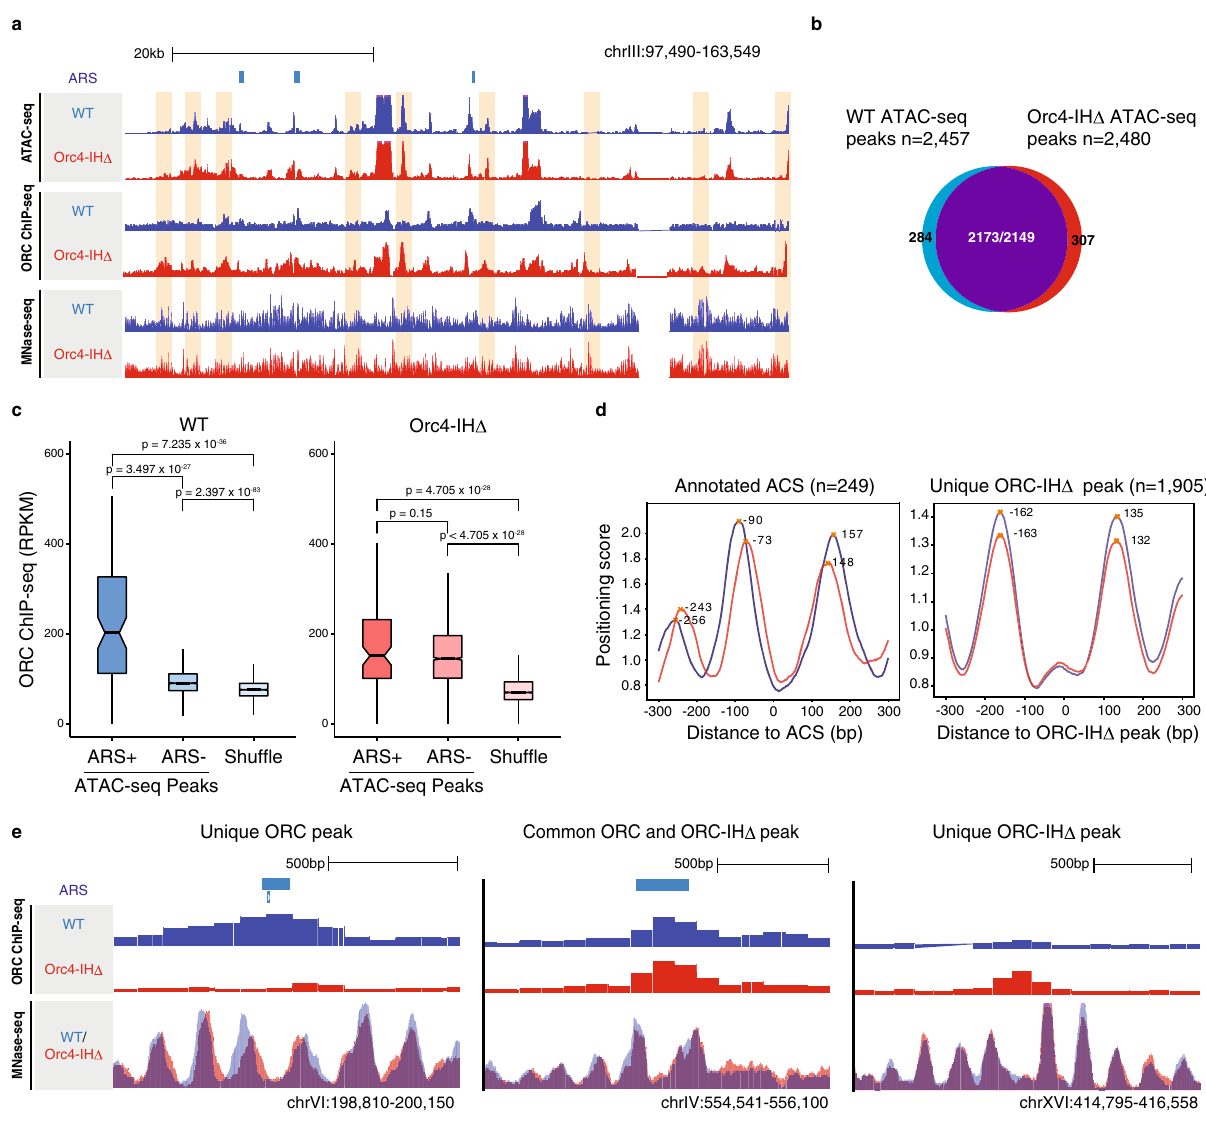
Fig. 6 ORC-IH Δ binds promiscuously to open chromatin and fails to facilitate nucleosome repositioning at ACSs. a A genome browser screenshot of a large region on chromosome III showing the chromatin accessibility, ORC enrichment, and nucleosome positioning in WT compared to Orc4-IH Δ . Orc4- IH Δ demonstrates a bias in binding to ATAC-seq peaks (orange shading). Annotated ARSs are denoted on the top track by light blue bars. Y -axis for all ChIP-seq, ATAC-seq, and MNase-seq tracks was adjusted to the same scale for each assay. b Venn diagram showing the high degree of overlap between ATAC-seq peaks de fi ned in WT ( n = 2457; blue) and Orc4-IH Δ cells ( n = 2480; red). Of these, 2173 WT and 2149 Orc4-IH Δ peaks overlapped by at least 1 bp (purple), while 284 and 331 peaks were identi fi ed as unique in WT and Orc4-IH Δ respectively. c Boxplot showing ORC ChIP-seq enrichment (RPKM) at ATAC-seq peaks, and shuf fl ed genomic loci in WT and Orc4-IH Δ cells. ATAC-seq peaks were further subdivided into peaks that overlap with OriDB annotated ARS (ARS + ) and those that do not overlap (ARS − ). In WT, pairwise comparisons show that there is signi fi cantly higher ORC binding at ARS + peaks ( n = 104) than ARS − peaks ( n = 2,612) and shuf fl ed regions ( n = 2,716). However, in Orc4-IH Δ , while higher enrichment was observed as compared to the shuf fl ed, there was no signi fi cant difference between ARS + and ARS − peaks. The upper and the lower bounds of the boxes denote the 75th and 25th percentiles of the data, respectively. The black lines within the boxes indicate the medians. P values are calculated by two-sided Wilcoxon rank-sum test. d Comparison of the mean nucleosome positioning score of WT (blue) and Orc4-IH Δ (red) surrounding annotated ACS regions and unique ORC-IH Δ ChIP-seq peaks (±300 bp). Loci are centered at the start of annotated ACS regions or peak summit of unique ORC-IH Δ peaks. Crosses demarcate the local maxima. Orc4-IH Δ cells show a signi fi cant difference in the spacing between − 1 and + 1 nucleosomes, speci fi cally at ACS regions compared to the WT. e Genome browser screenshots illustrates WT and mutant ORC-binding sites, and their corresponding nucleosome positioning. Examples are shown of ORC ChIP-seq peaks de fi ned as unique to WT (left), common between WT and Orc4-IH Δ (middle), and unique to Orc4-IH Δ (right). Orc4-IH Δ speci fi c difference in nucleosome positioning was detected at the unique to WT region. The ORC ChIP-seq normalized signal (RPKM) and MNase-seq normalized signal (RPKM) are shown for both WT (blue) and Orc4-IH Δ (red). Annotated ARSs are denoted on the top track by light blue bars. Y -axis of ORC ChIP-seq and MNase-seq tracks were set to the same scale for each